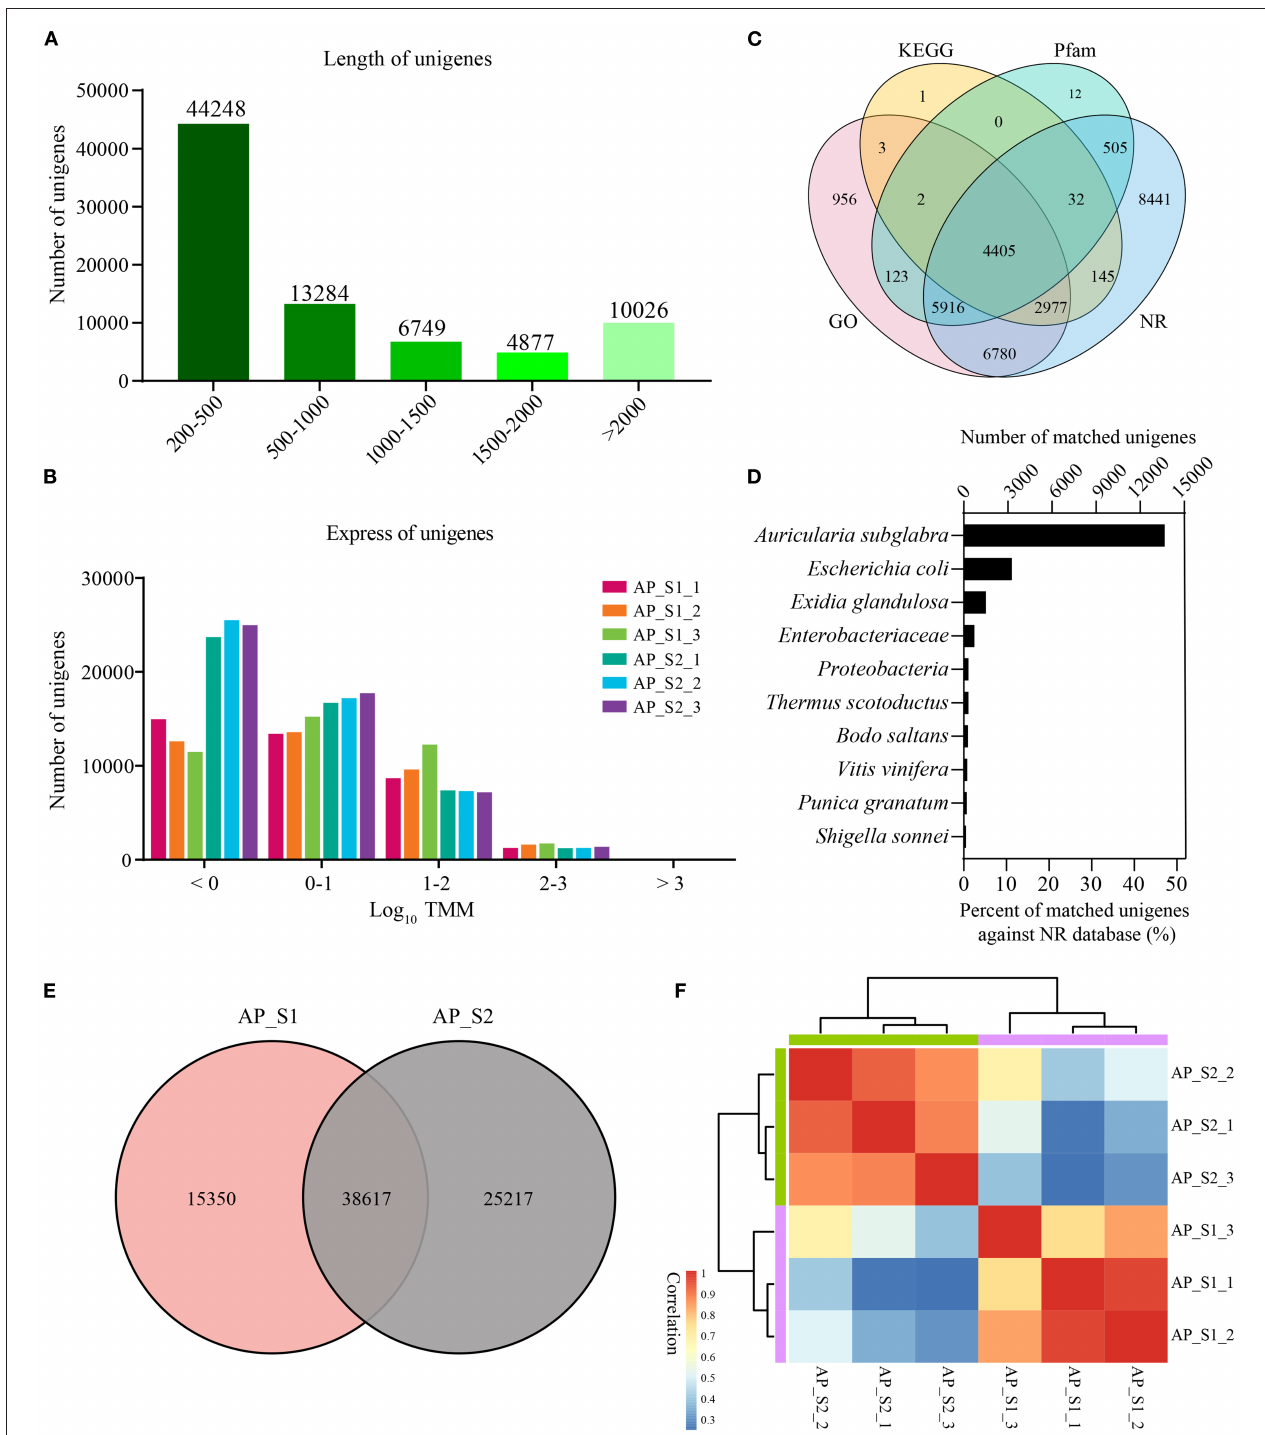
FIGURE 2 | Overall results for the Illumina sequencing. (A) Distribution of the unigenes of different lengths. (B) Expression level of the unigenes among the two different harvesting periods of A. polytricha . (C) Venn diagram for the different functional annotations of the A. polytricha unigenes. (D) Top-hit species distribution of the A. polytricha unigenes based on the non-redundant (NR) annotation. (E) Venn diagram showing the number of coexpressed unigenes in “AP_S1” and “AP_S2”. (F) Heatmap of correlation between all the samples.